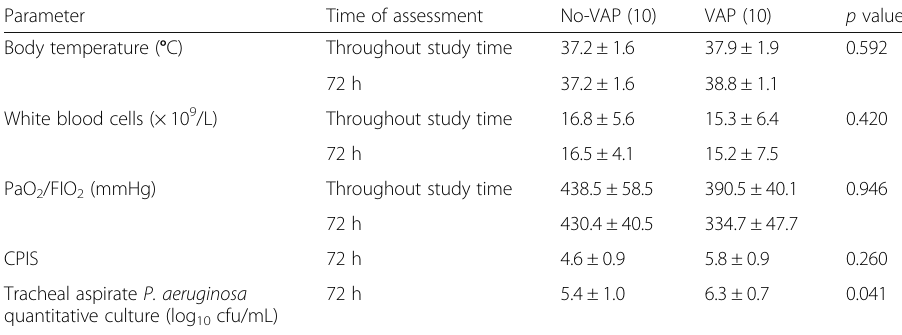
Table 3 Clinical and microbiology variables between animals with or without VAP